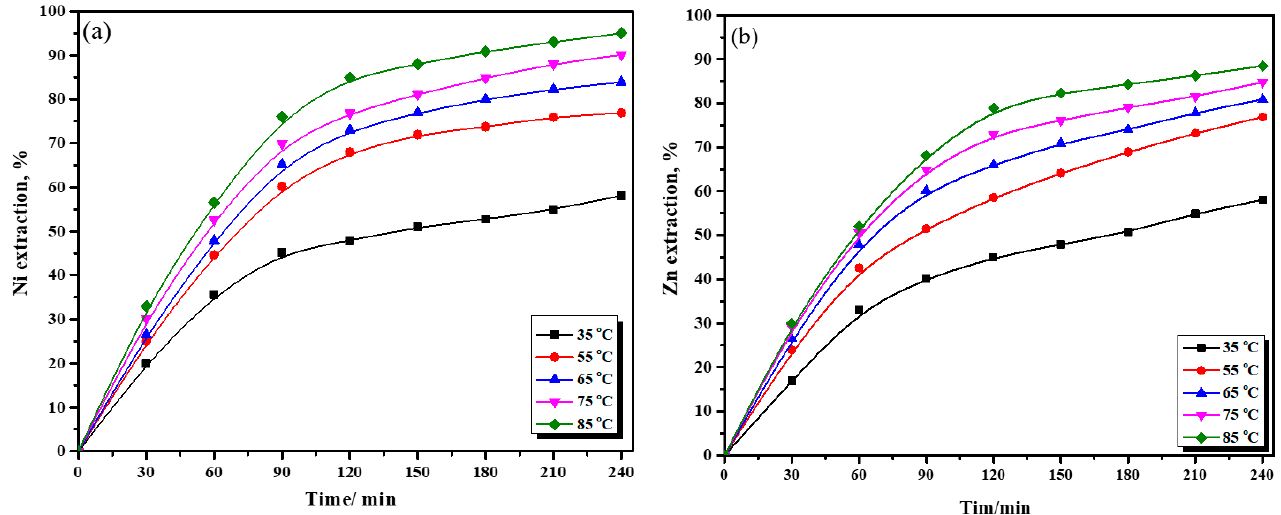
Figure 16. Effect of leaching time on the nickel ( a ) and zinc ( b ) dissolution at different temperature.